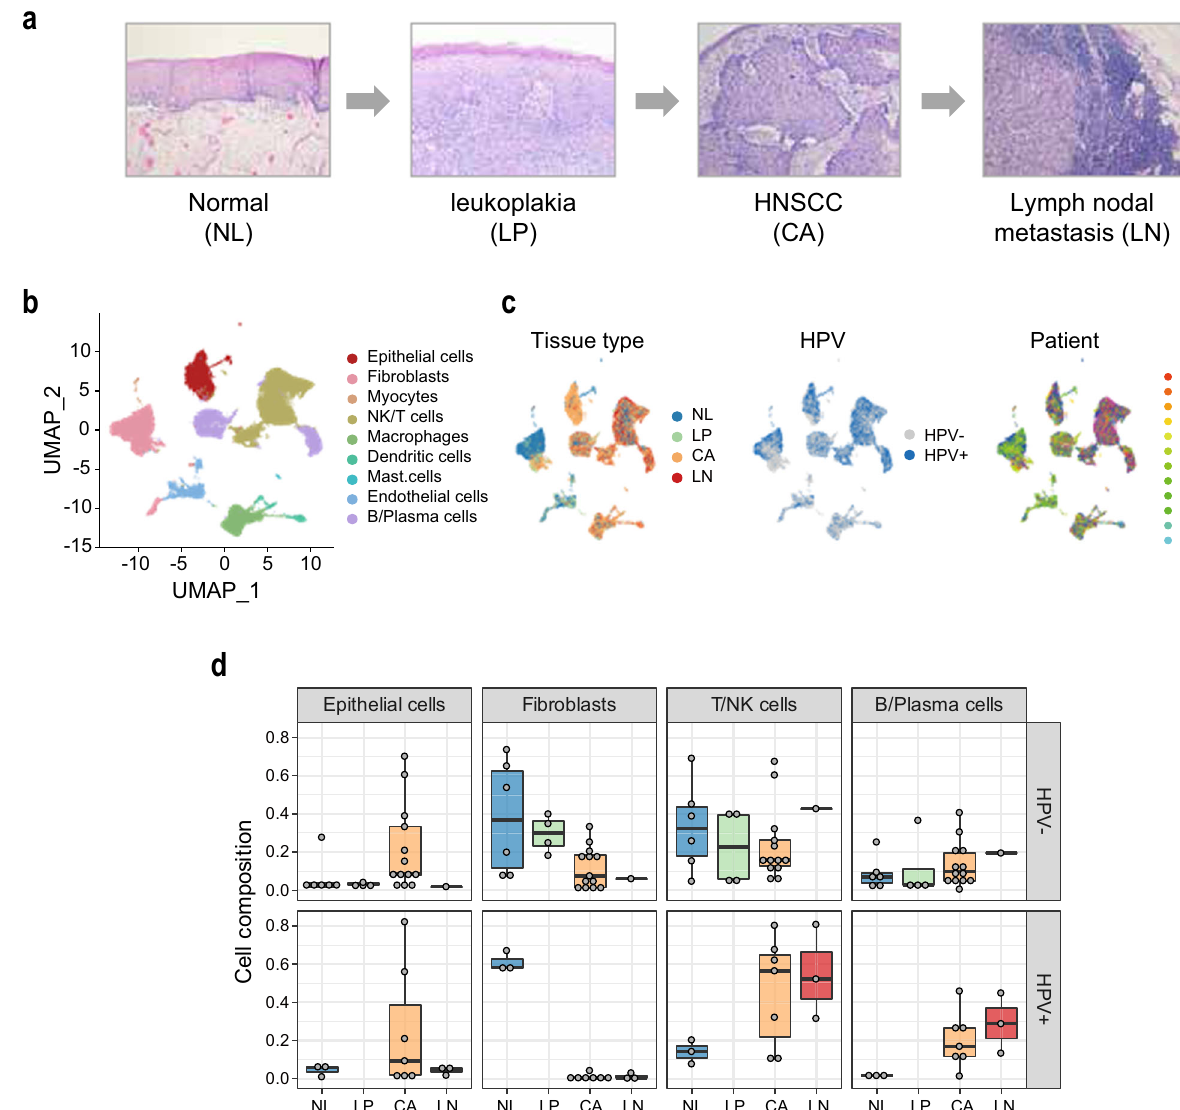
Fig.1|scRNA-seqpro fi lingofthestepwiseprogressionofHNSCC.a Aschematic diagram of the stepwise progression of HNSCC. b Cell types of the 54,239 cells are indicated in a UMAP plot. c Distribution of tissue types, HPV infection status, and individual patients are shown. d Cell compositions of the major cell types of epi- thelialcells( n =6106), fi broblasts( n =12,336),NK/Tcells( n =17,869),andB/Plasma